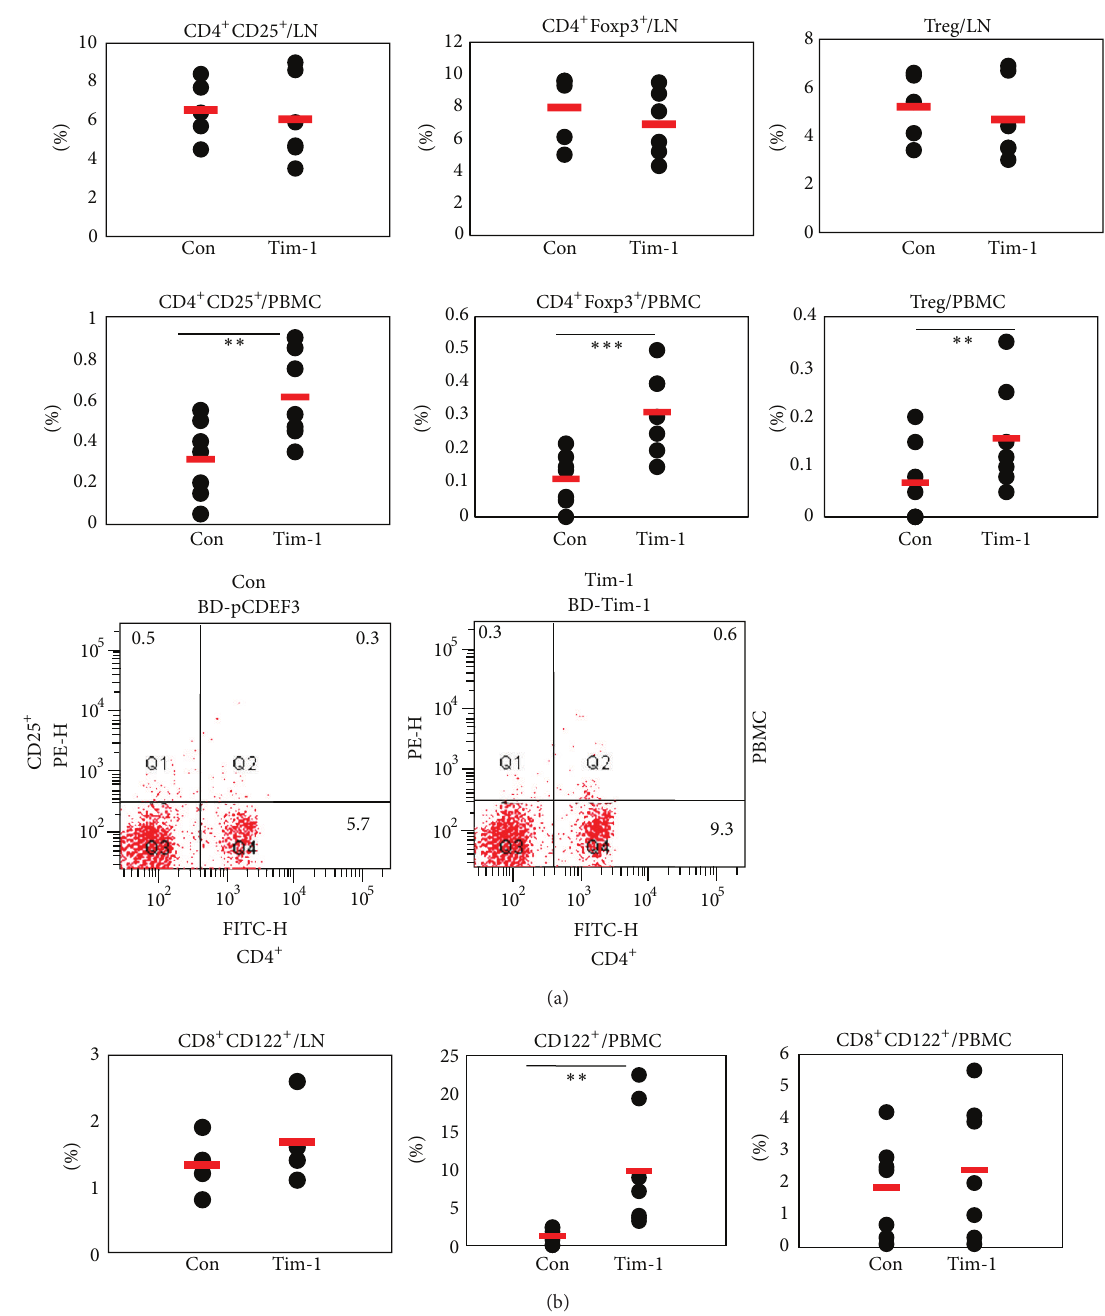
Figure5:ThefrequenciesofTregcellsinPBMCswereaffectedin Tim-1 vectorinjectedBehc¸et’sdisease(BD)mice.TwotypesofTregcellswere confirmed in LN and PBMCs after Tim-1 administration to BD mice. (a) The frequencies of CD4 + CD25 + , CD4 + Foxp3 + , and Treg cells were compared between the control and Tim-1 vector injected groups. Bottom panel shows CD4 + CD25 + in PBMCs by FACS. (b) CD8 + CD122 + T cells tended to be upregulated compared to those in the control group, but the difference was not significant. CD122 + cells increased significantly in the Tim-1 vector injected group ( 𝑛 = 5–8) ( ∗∗ 𝑃 < 0.05 , ∗∗∗ 𝑃 < 0.01 ). Con: control vector injection to BD mice, Tim-1: Tim-1 vector injection to BD